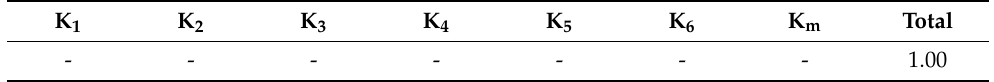
Table 11. The subjective importance q j .